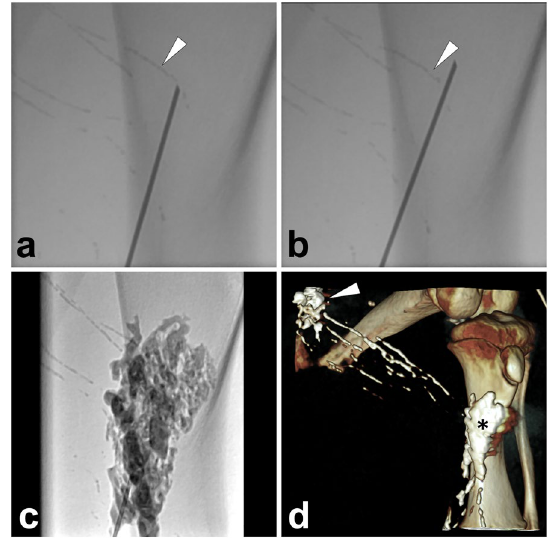
Fig. 12 Illustration of percutaneous ALVE using a “cutting-off” technique. In a PLL pig model, puncture the needle targeting the afferent lymphatic vessel ( white arrowhead ) under fluoroscopy ( A , paralleled flat detector position). Then, cut off the target lymphatic vessel ( white arrowhead ) ( B , paralleled flat detector position) and inject 1 ml NBCA/lipiodol mixture (1:2) when simultaneously withdrawing the needle. Repeat the same operations to ensure all afferent lymphatic vessels are embolized ( C ). After the ALVE procedure, the volume rendering image of the CT scan demonstrated the relationship between the PLL site ( white arrow ) and the embolized region ( * ) ( D ). Images were from Pig No. 1 . Abbreviations: ALVE, afferent lymphatic vessel embolization; PLL, postoperative lymphatic leakage; NBCA,